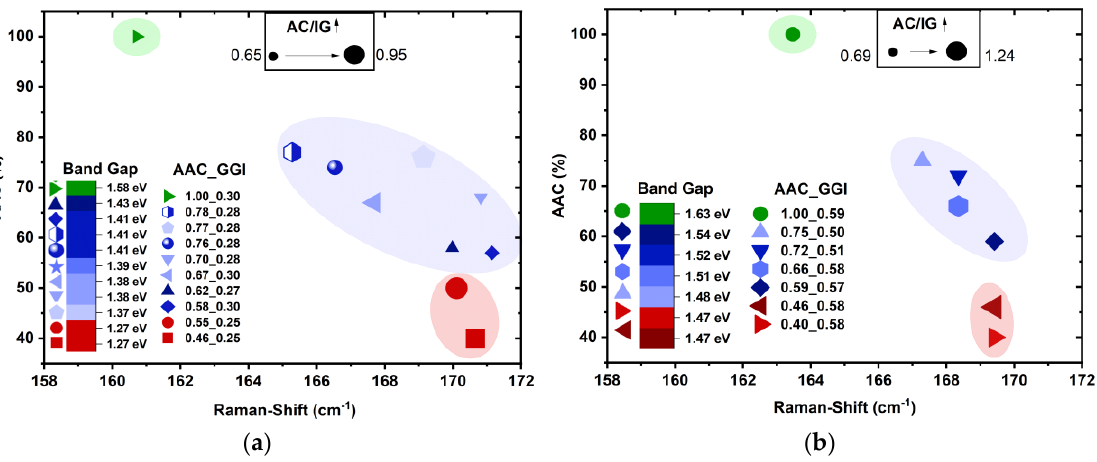
Figure 4. Raman shift of ACIGSe A 1 mode related with AAC ratio, AC/IG ratio (symbol size), and band gap values (color code) for ( a ) low (0.25 – 0.30) and ( b ) high (0.50 – 0.59) GGI ratios.